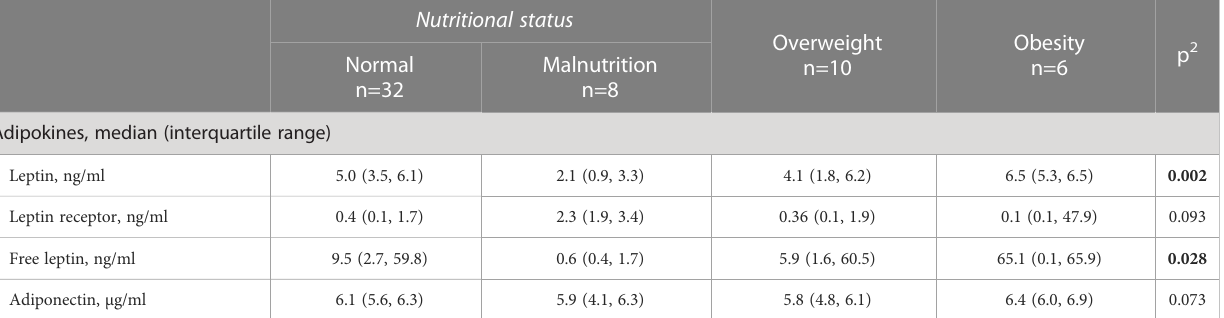
TABLE 2 Baseline adipokines serum levels, strati fi ed by nutritional status (n=56) 1 .